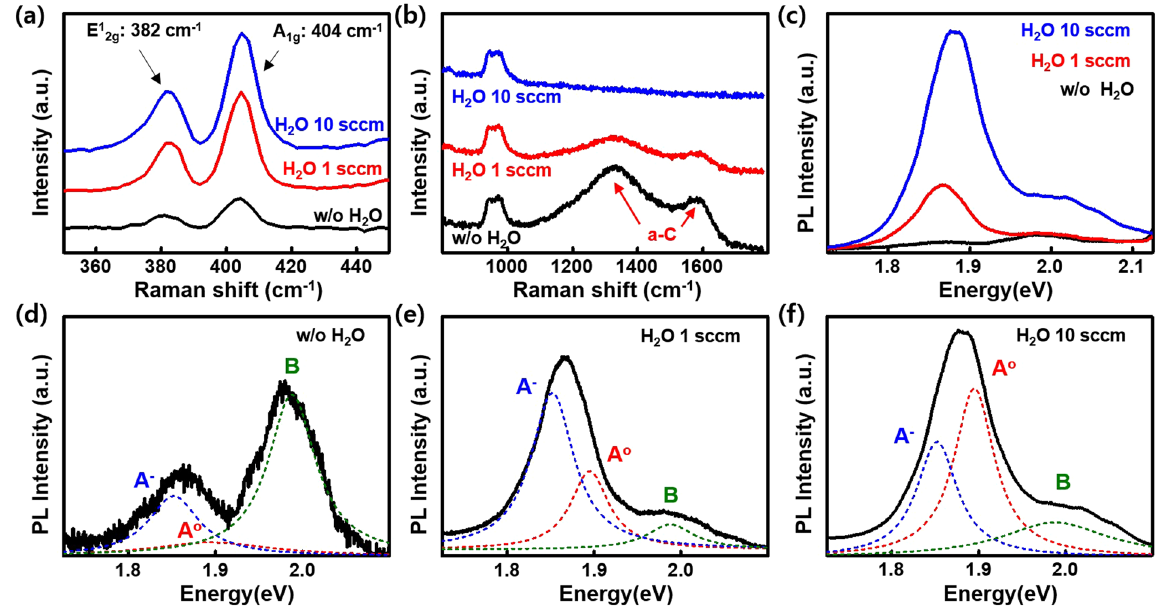
Figure 2. Effect of water supply I: the removal of a-C. ( a , b ) Raman and ( c ) PL spectra of MoS 2 specimens with/ without water supply (black: without (w/o) water, red: H 2 O 1 sccm, and blue: H 2 O 10 sccm, respectively). Each Raman spectrum for ( a ) and ( b ) display the presence of MoS 2 and a-C, respectively. ( d , e ) Deconvoluted PL spectra of ( d ) w/o water, ( e ) H 2 O 1 sccm, and ( f ) H 2 O 10 sccm water with Lorentzian curves at 1.852 eV (blue, multiexciton, A − ), 1.895 eV (red, neutral exciton, A°), and 1.988 eV (green, neutral exciton, B),